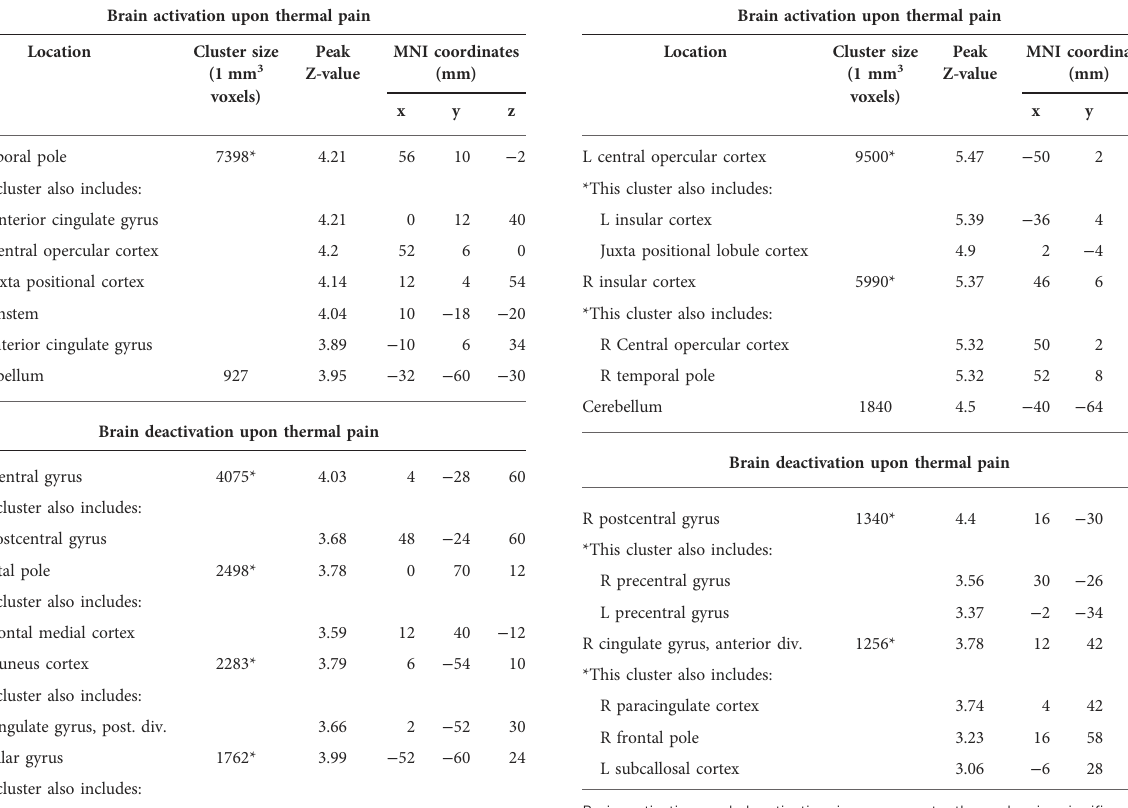
Brain activation and deactivation in response to thermal pain, signi fi cant at p <0.05 cluster corrected. A Z-threshold of 2.3 was used. B=Bilateral; L=Left;